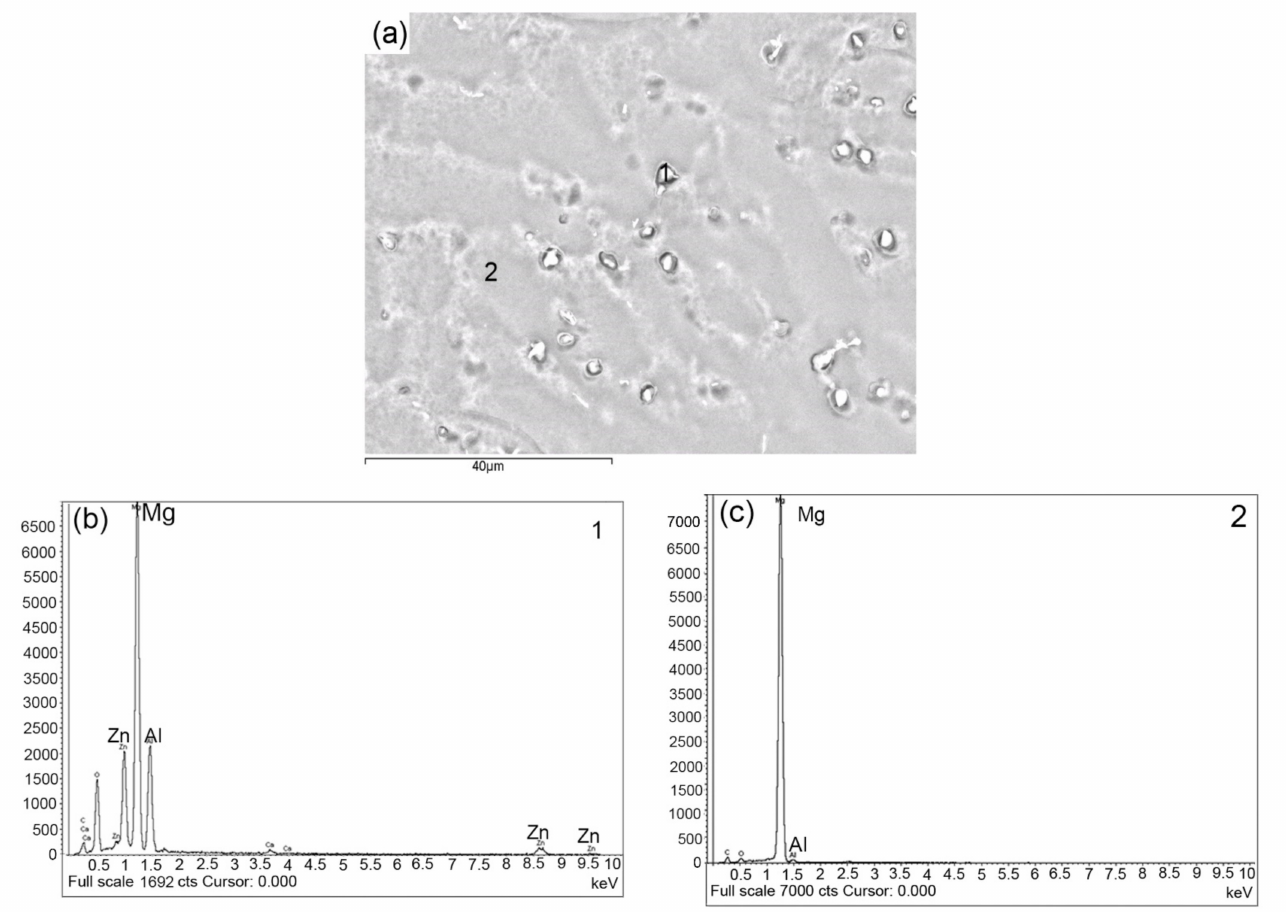
Figure 5. SEM images of the weld fusion zone with 4 mm/s welding speed. ( a ) second phase particles, ( b ) EDS spectrum of point 1, and ( c ) EDS spectrum of point